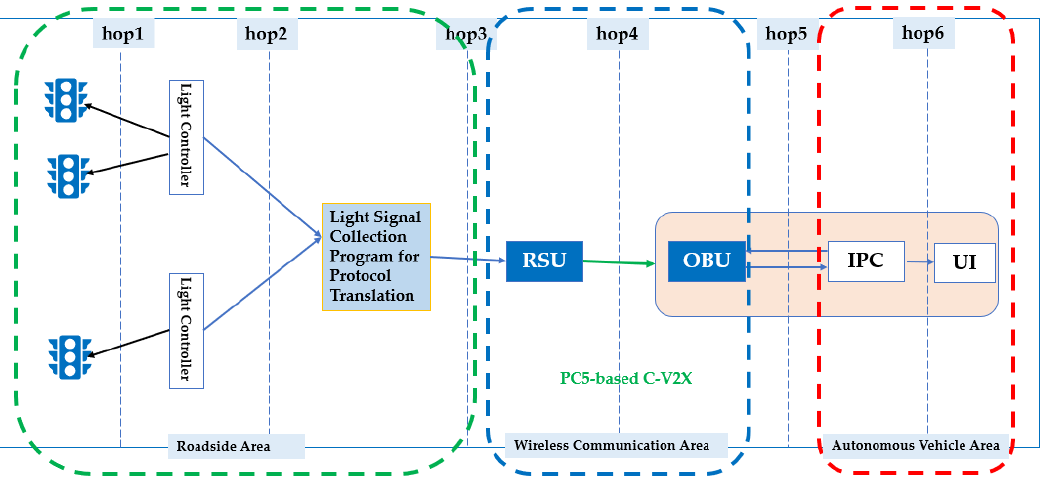
Figure 6. C-V2X SPAT Application System Architecture.